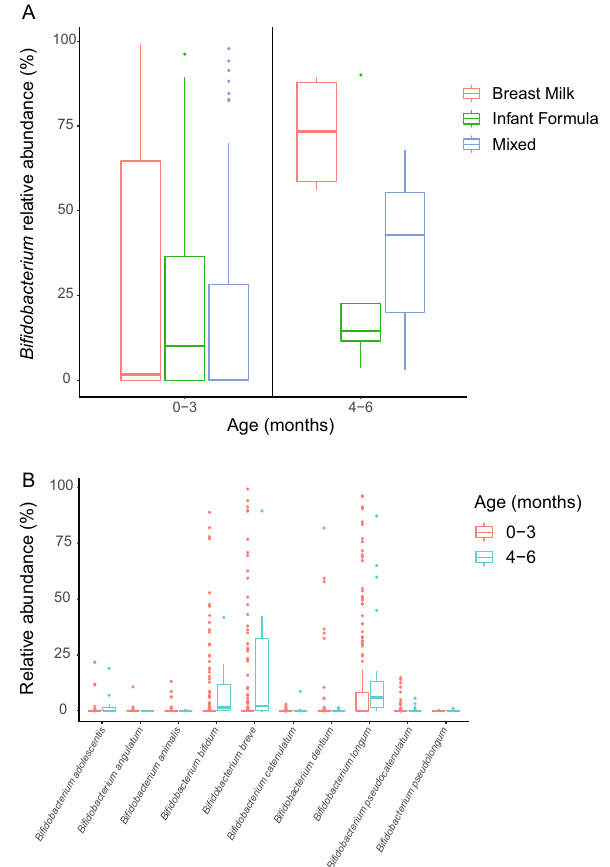
Figure 2. Relative abundance of Bifidobacterium at the genus and species level. ( A ) Bifidobacterium relative abundance (%) grouped by age and diet. ( B ) Relative abundance (%) of all species identified within the Bifidobacterium genus and grouped by patient age. The lower and upper hinges of the box plots correspond to the first and third quartiles (the 25th and 75th percentiles), while internal hinge is the 50th percentile (median). Data beyond the end of the whiskers are "outlying" points and are plotted